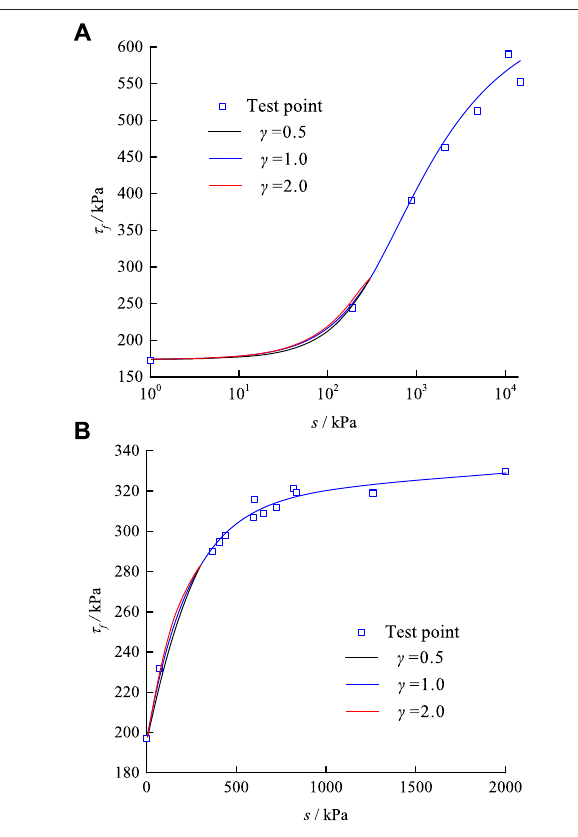
FIGURE 11 | Finite element model of the